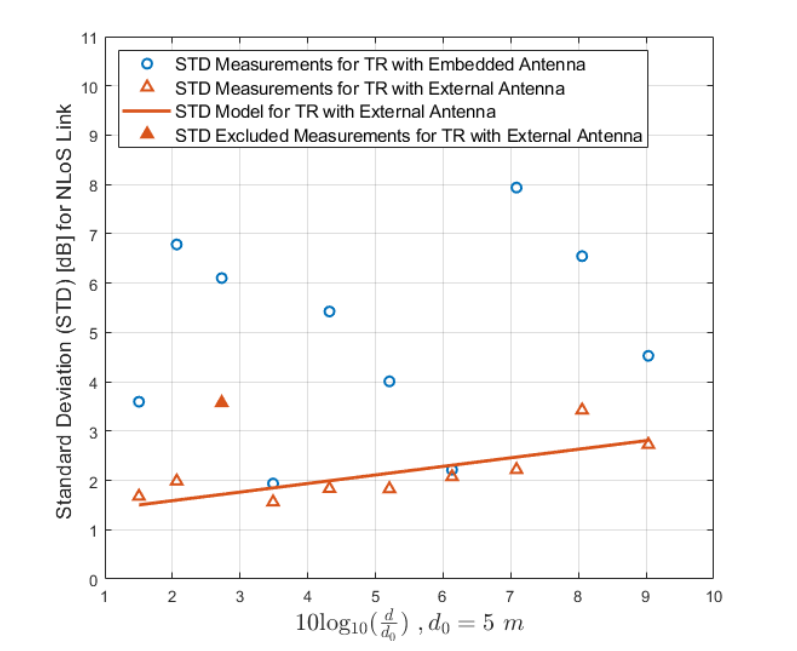
Figure 7. Standard deviation at each location for the Non − Line − of − Sight links using both types of IQRF